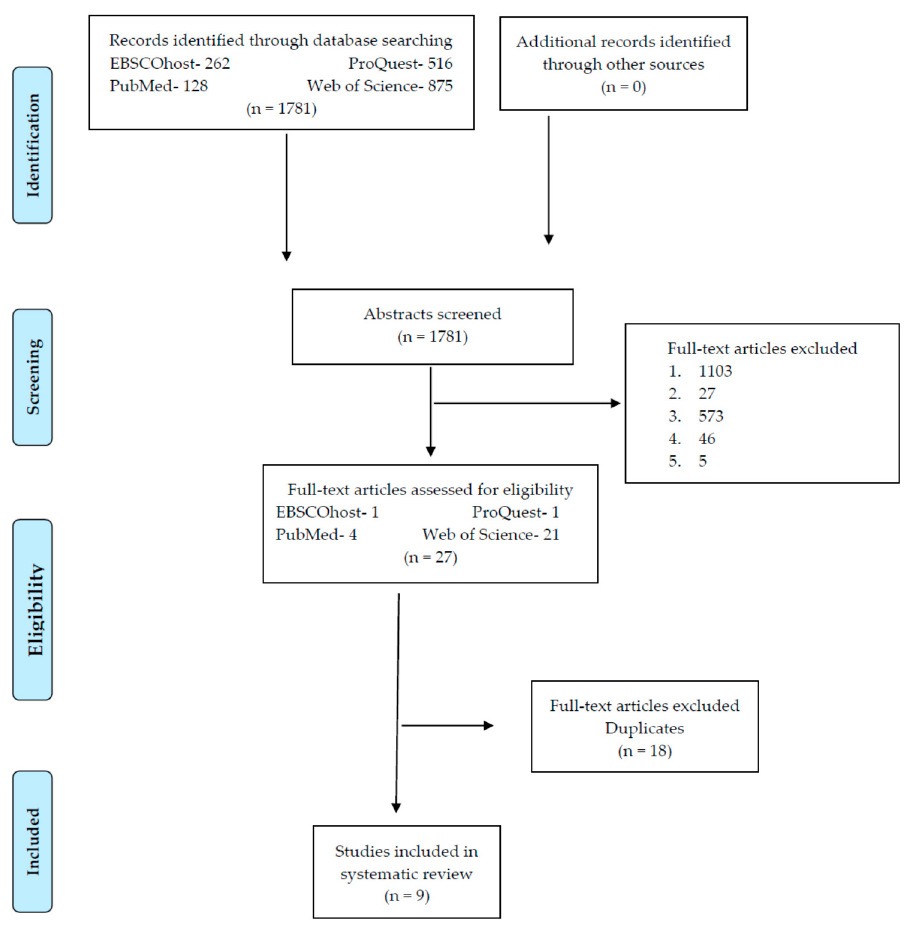
Figure 1. Flow chart of the screening process for the selection of included clinical trials [52–54].